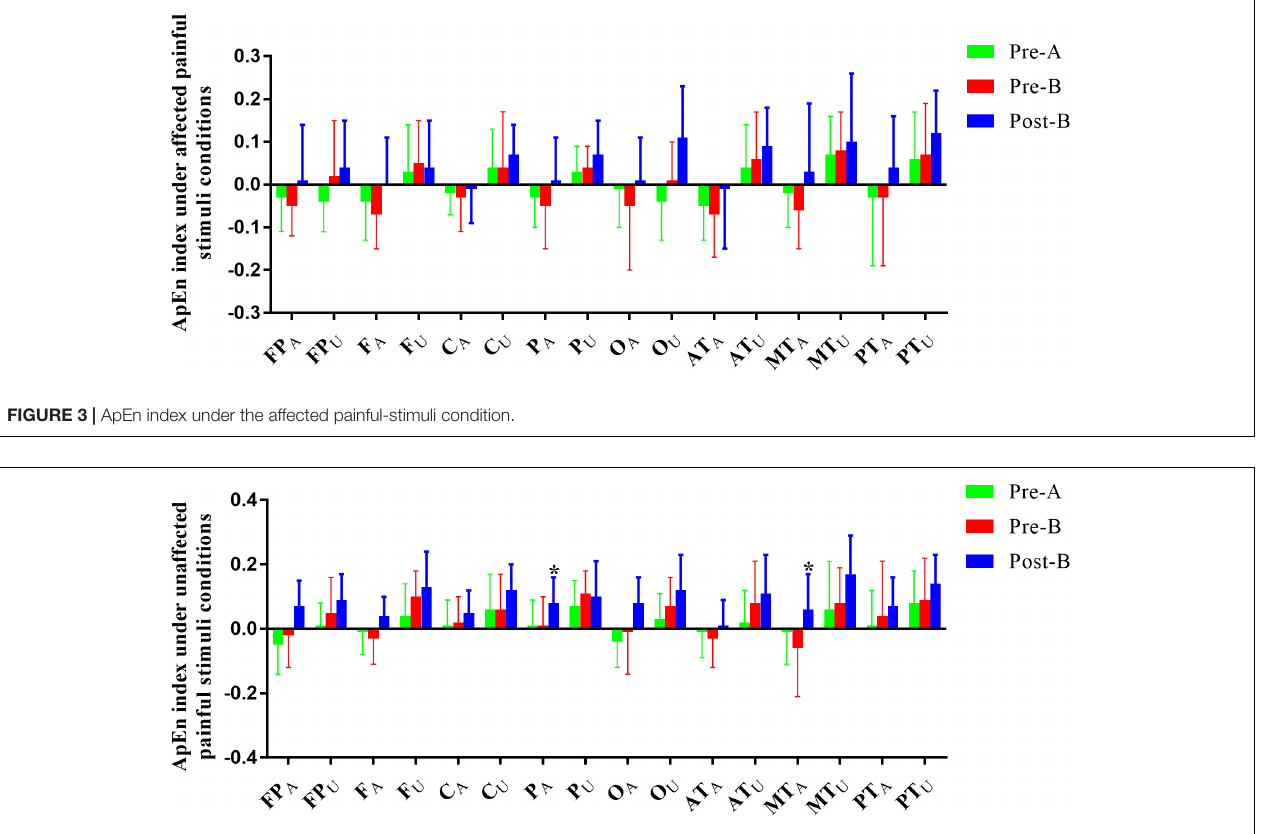
FIGURE 4 | ApEn index under the unaffected painful-stimuli condition. * p < 0.05 was considered statistically